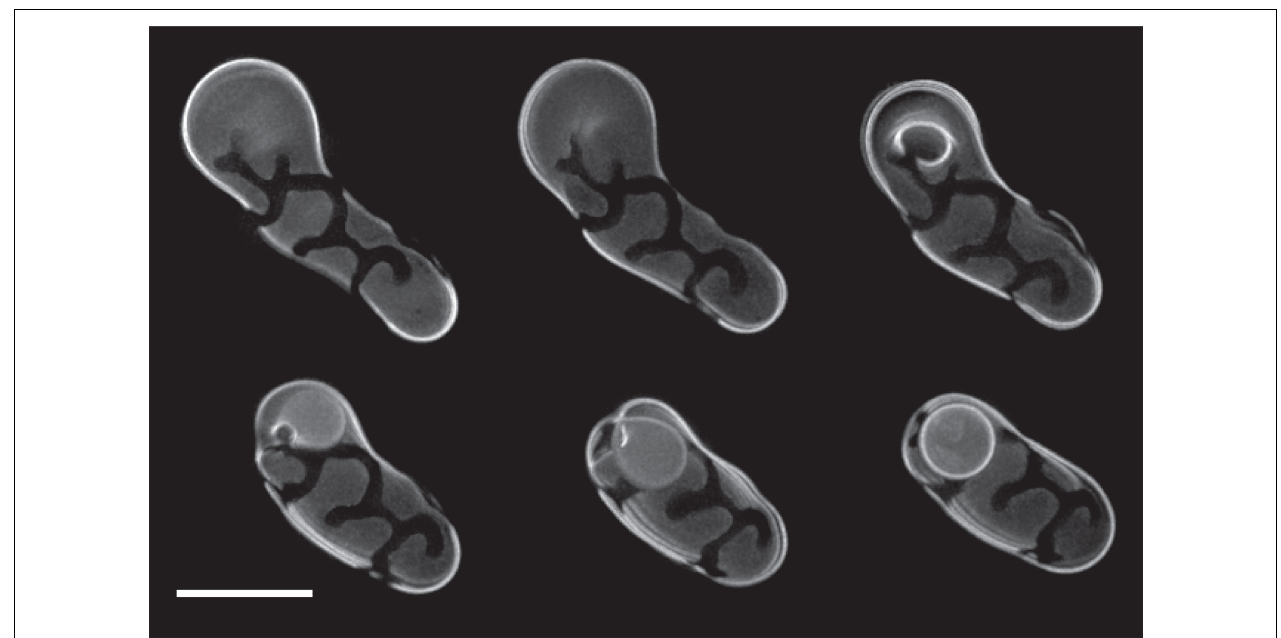
Involution of the L d phase (labeled with Rho-DPPE) resulted in the formation of an internalized daughter GUV.The image series shows the lower hemisphere of the vesicle (deconvolved Z -stack) at different time points. Scale bar: 10 μ